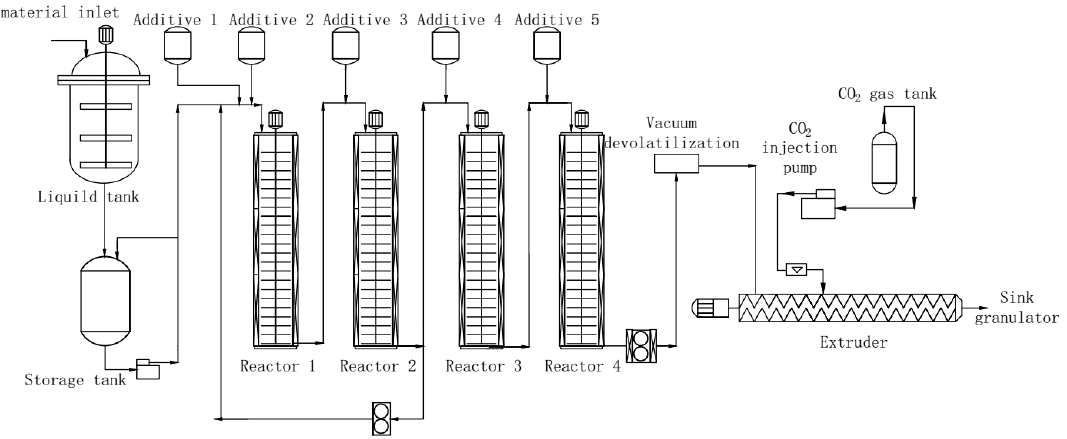
Figure 1. Schematics of preparation of acrylonitrile butadiene styrene (ABS) resin with low volatile organic compound (VOC) using the supercritical extraction method.